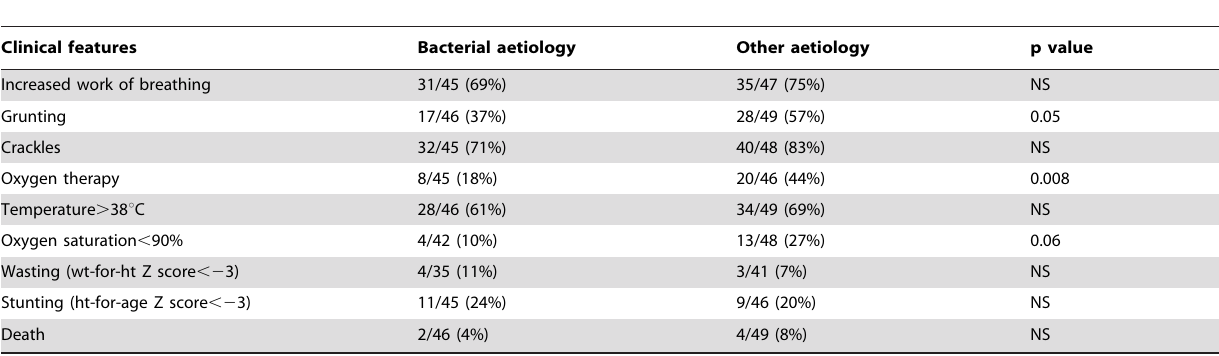
NS=not significant.